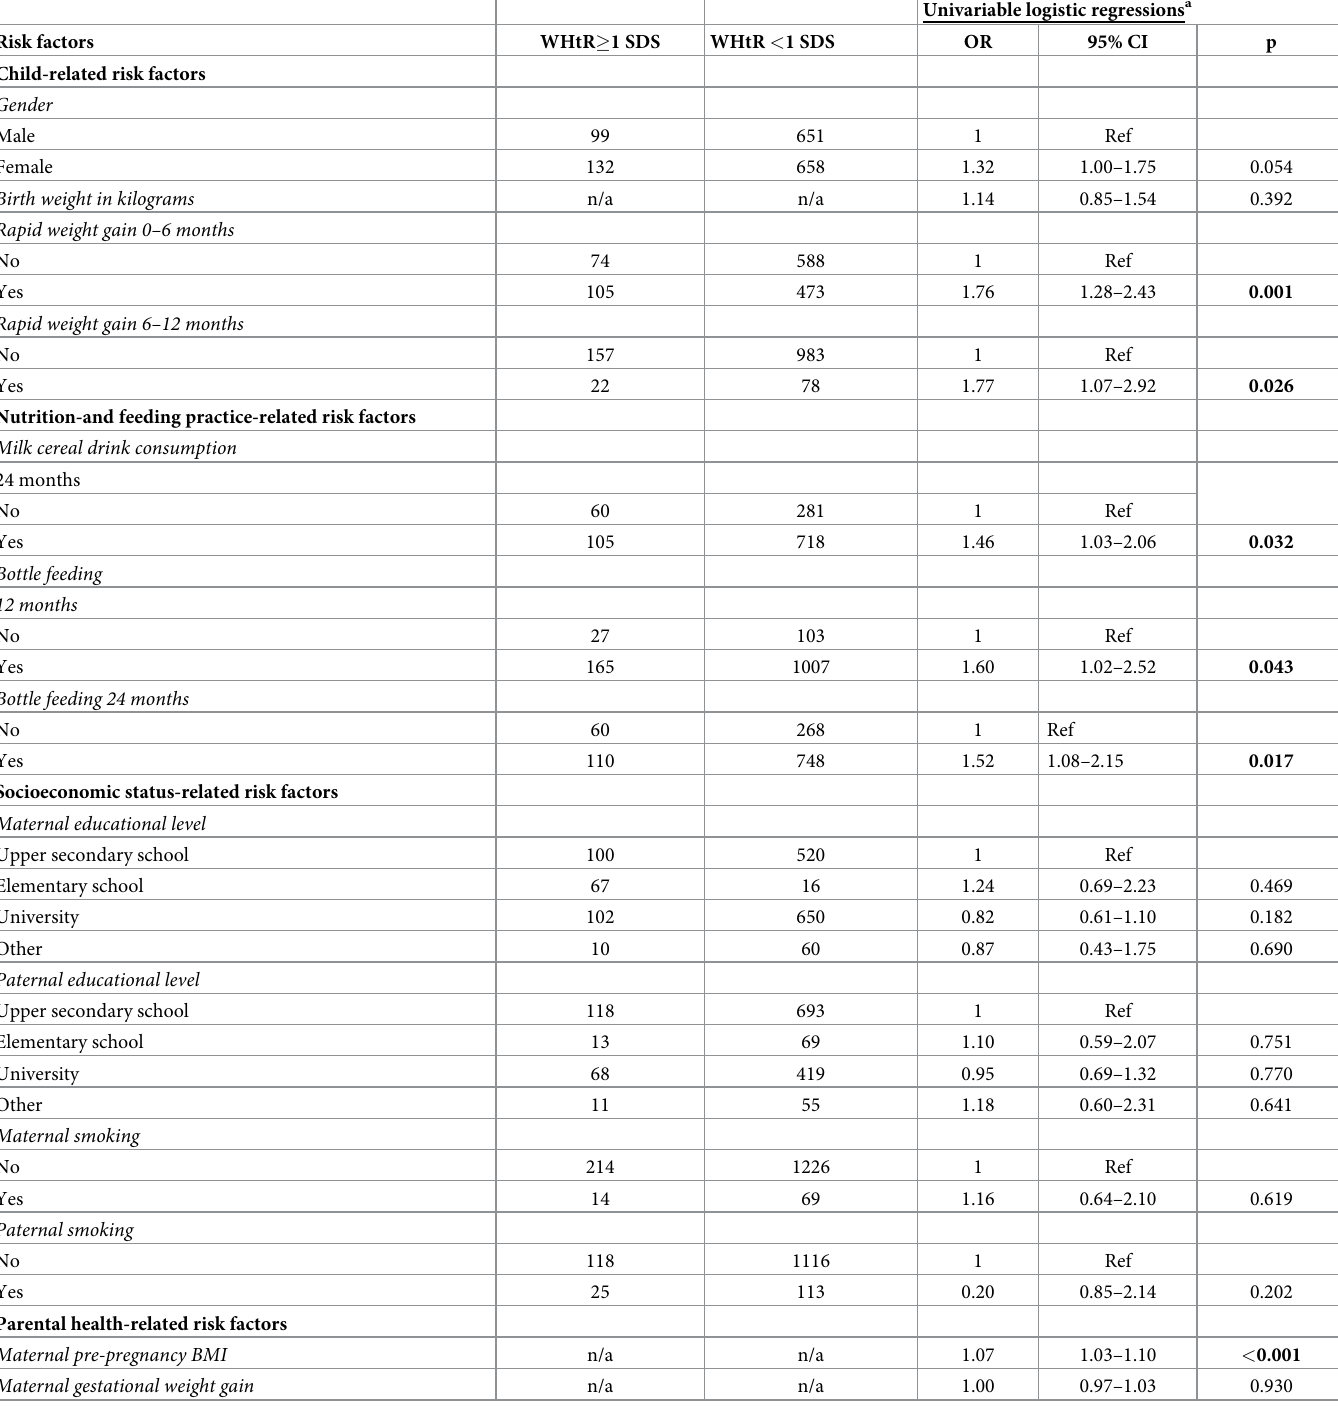
Table 2. Odds ratios and 95% confidence intervals for risk factors for an elevated WHtR SDS at five years of